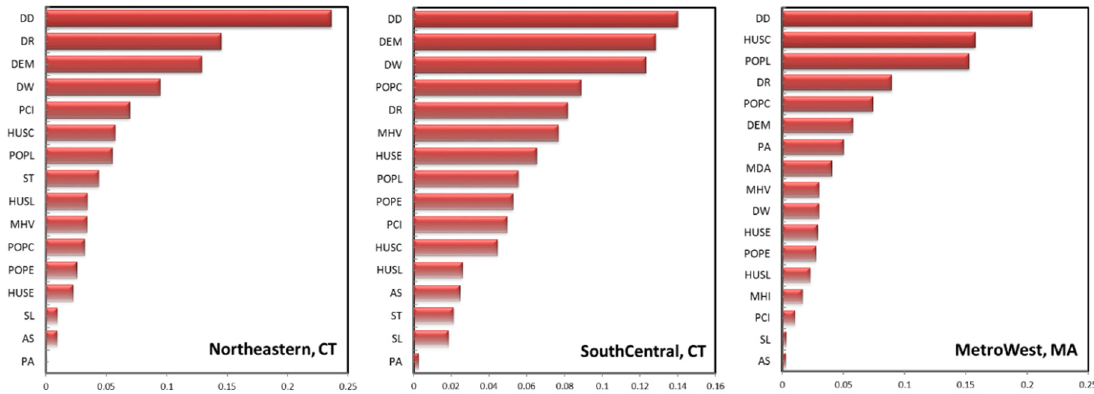
Figure 5. Results of the random forests (RF) approach for assessing the driving forces of LUCC.